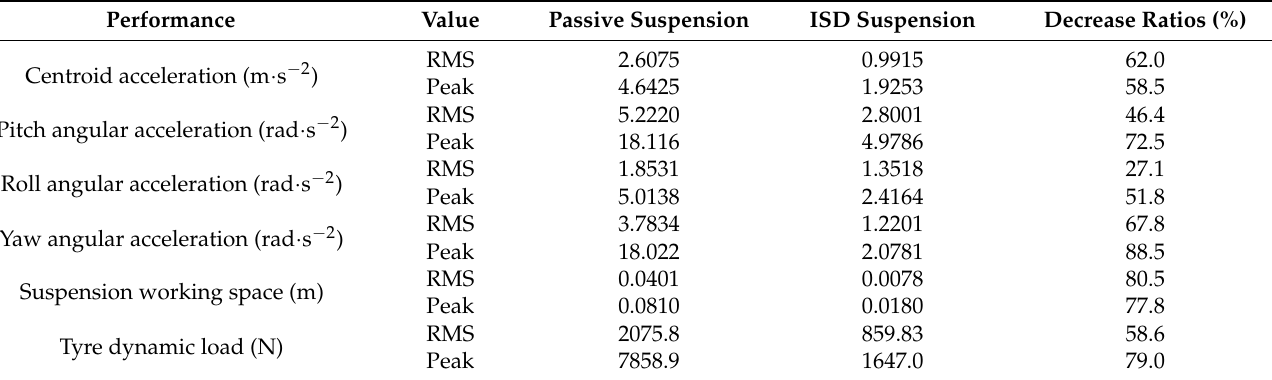
Table 4. Comparison of performance indicators under coupled road